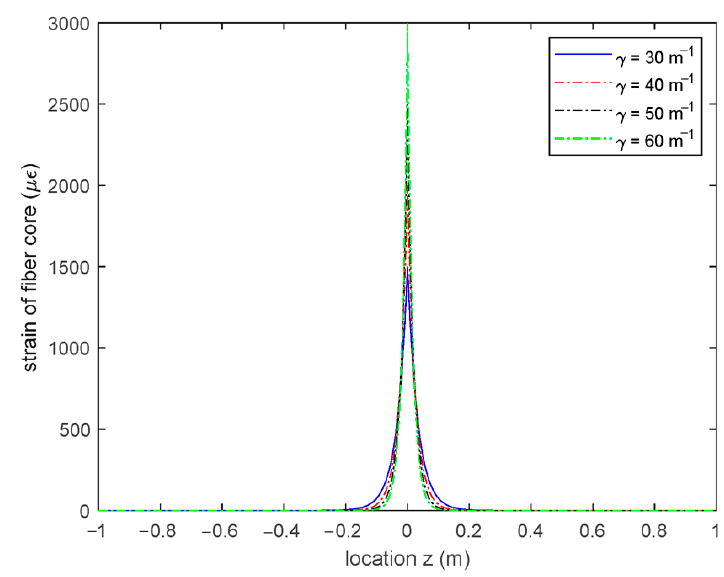
Figure 6. Strain distribution of fiber core with di ff erent shear lag factors (COD = 0.1 mm and ε m = 0 µε ).